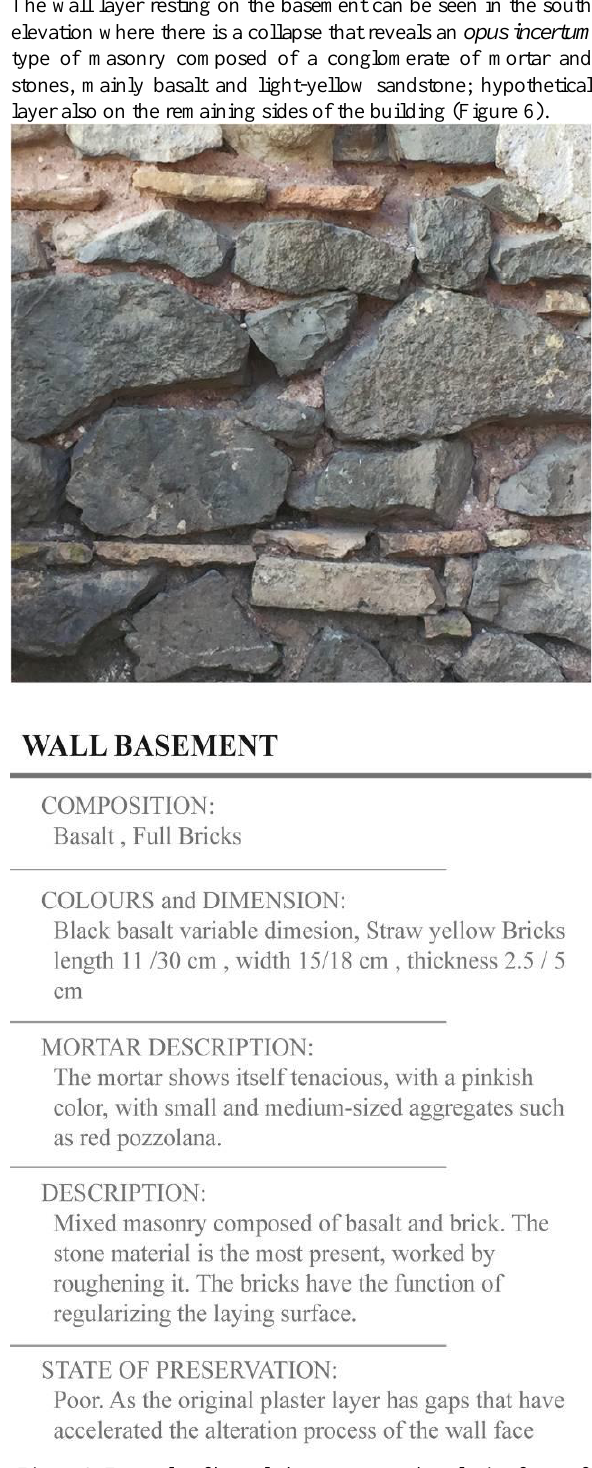
Figure 6. Example of knowledge, survey and analysis of one of the present wall hangings of the Casale delle Vigne Viola.